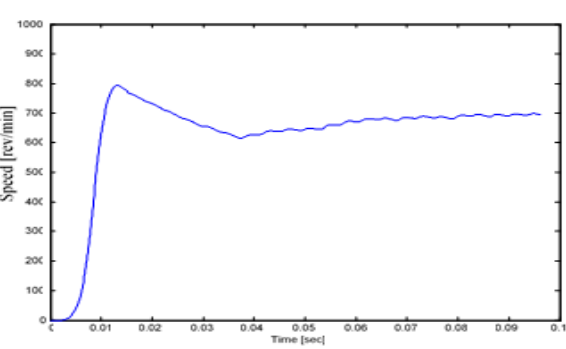
Fig. 13. Speed waveform of 4-phase machine including the control i.e., current chopping